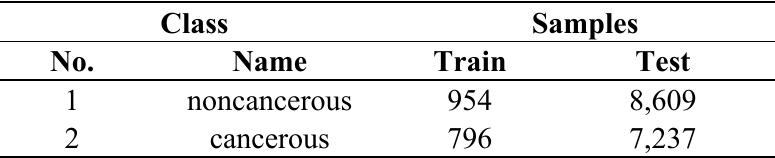
Table 1. The two classes (noncancerous and cancerous) and the training and test set for each class.